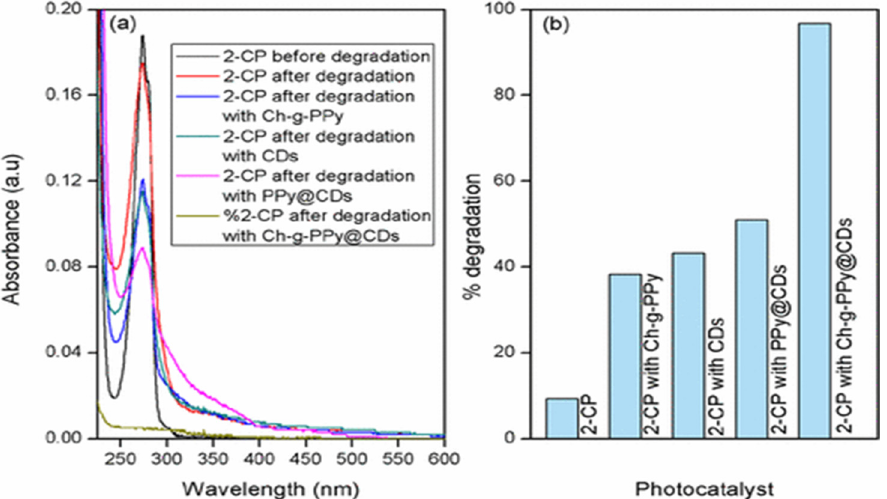
Figure 11. ( a ) Photocatalytic degradation of various nanomaterials via sunlight irradiation after 90 min, ( b ) efficiency of degradation comparing catalysts such as chitosan-grafted polypyrrole (Ch-g-PPy), polyrrole-based carbon dot (PPy@CD) and chiton-grafted polypyrrole carbon dot